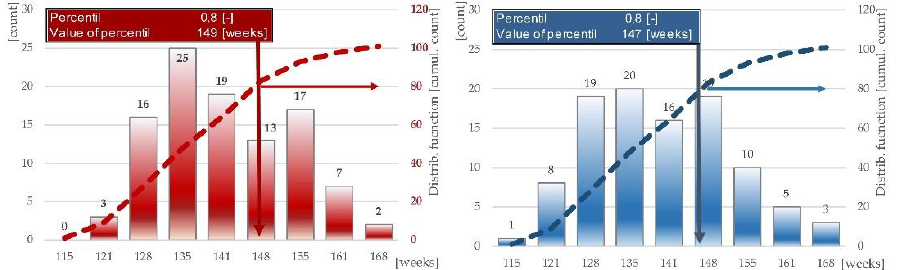
Figure 6. Frequency distribution of the end-date values and their distribution function (linear and logistical variant). (Source: authors).